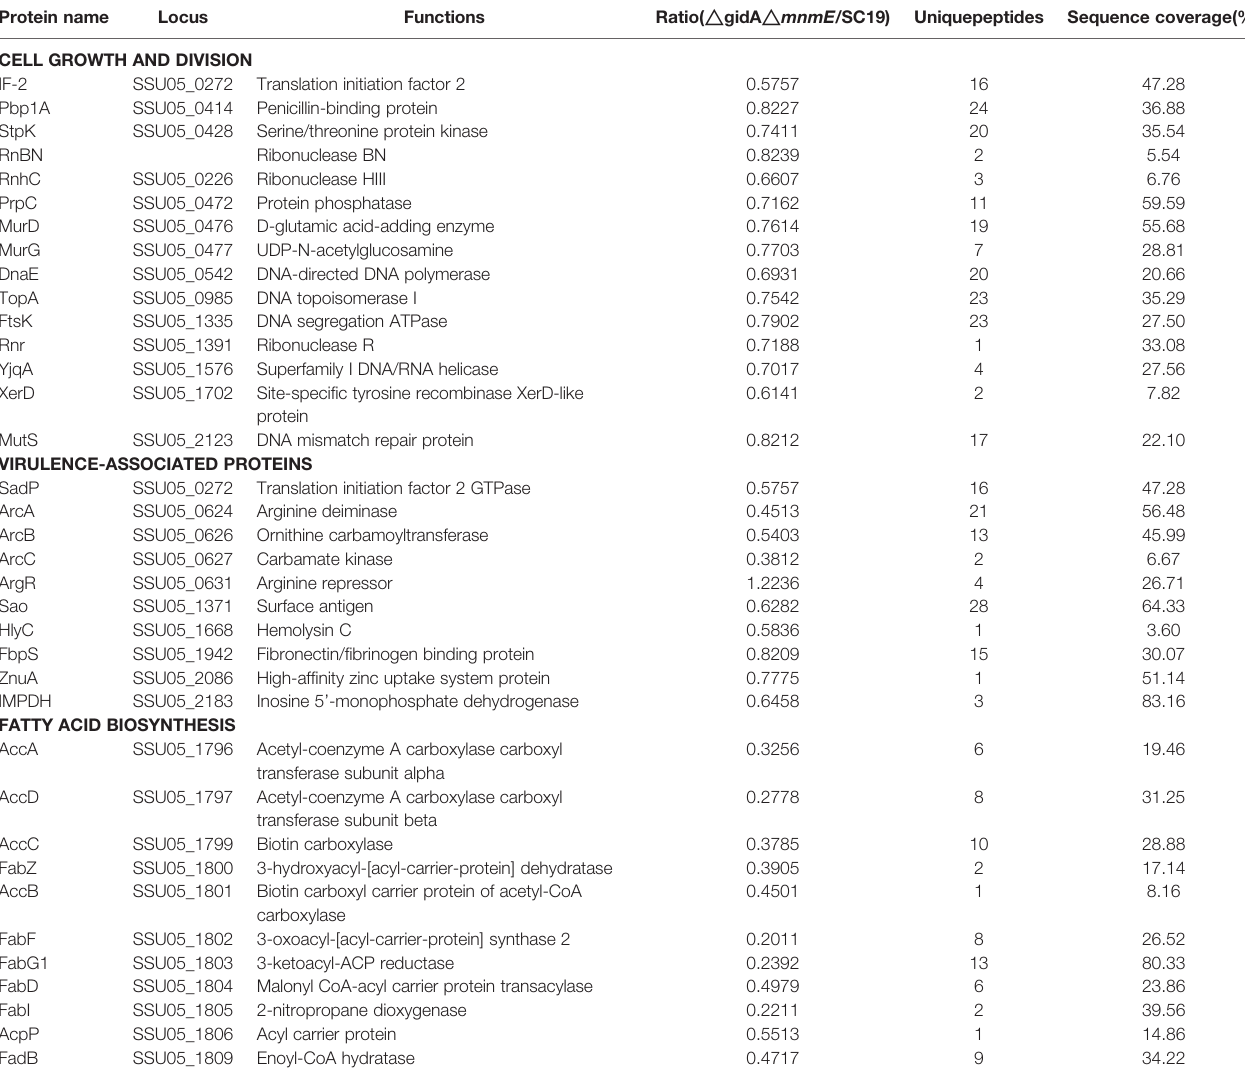
TABLE 4 | Differentially expressed proteins associated with cell growth and division, virulence, and fatty acid biosynthesis between the △ gidA △ mnmE and SC19. Protein name Locus